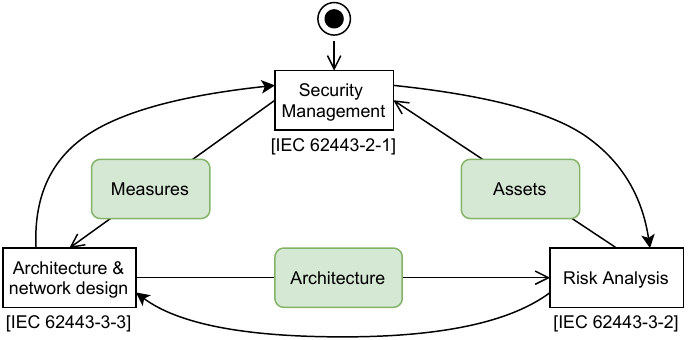
Figure 5. Security management, system architecture and network design, and risk analysis